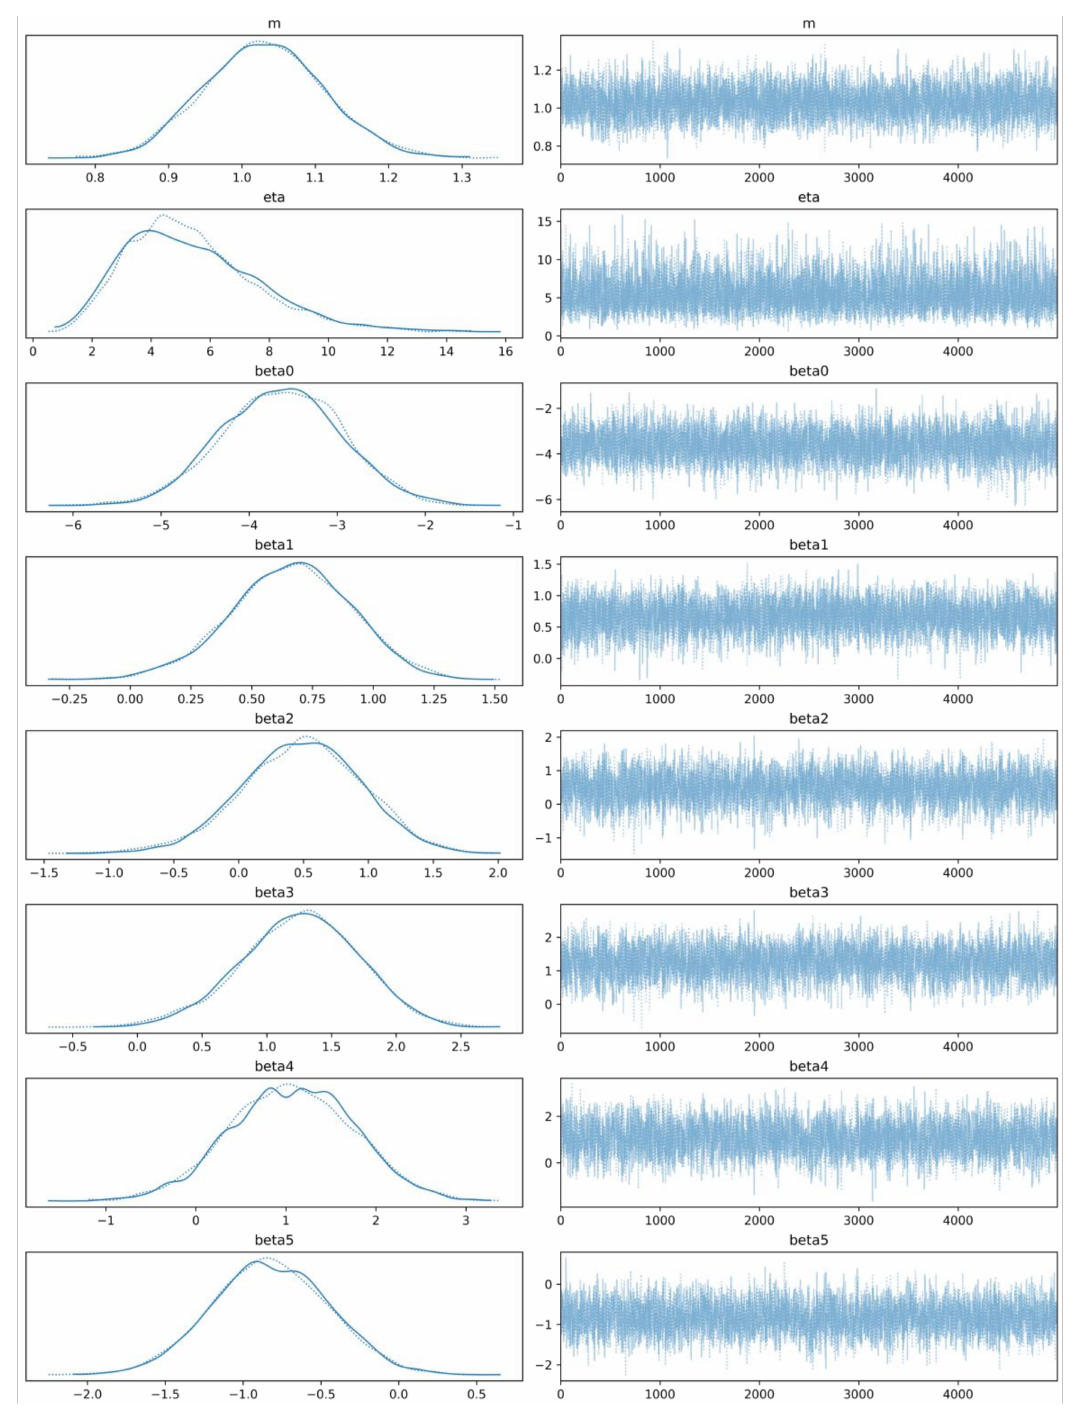
Figure 4. Sampling results of the improved Weibull